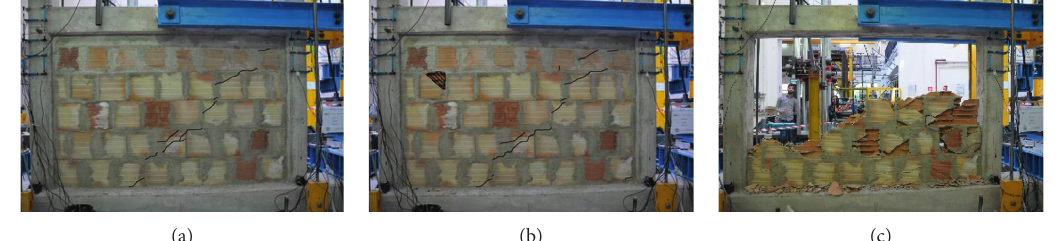
Figure 5: Example of damage evolution (adapted form De Risi et al. (2018)). (a) Slight. (b) Moderate. (c)